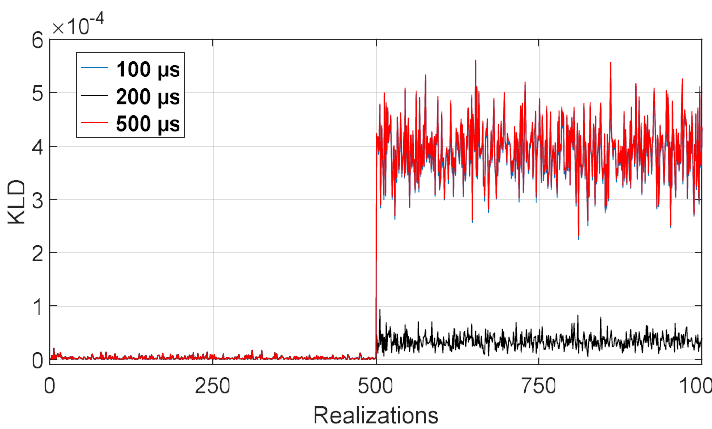
Figure 17. KLD results for 3 OSF at 20 rad/s, 50% of load and SNR = 20 dB.